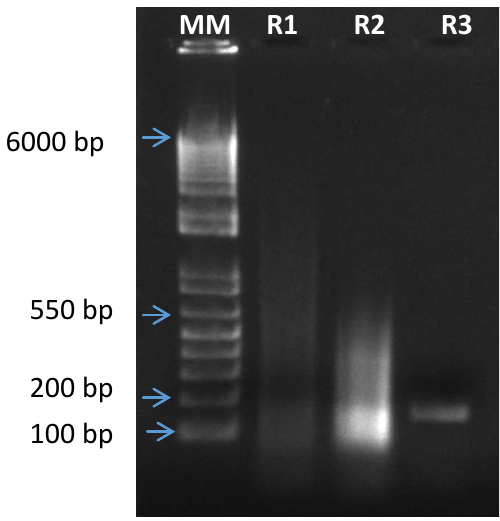
Figure 2 : Extractions with different incubation temperatures with proteinase K, horse: Molecular market 1kb Plus (MM); 15min (C1), 30min (C2), 45min (C3)